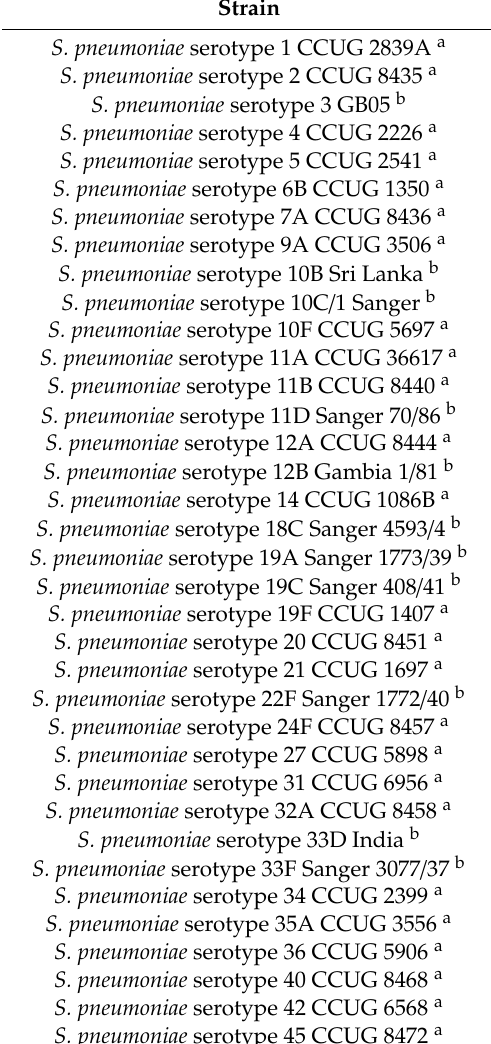
Table 1. Pneumococcal collection type strains used in the